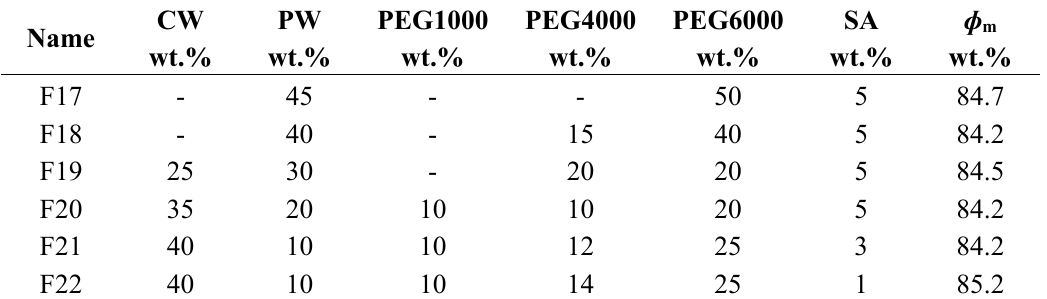
Table 2. Non-polyolefin based